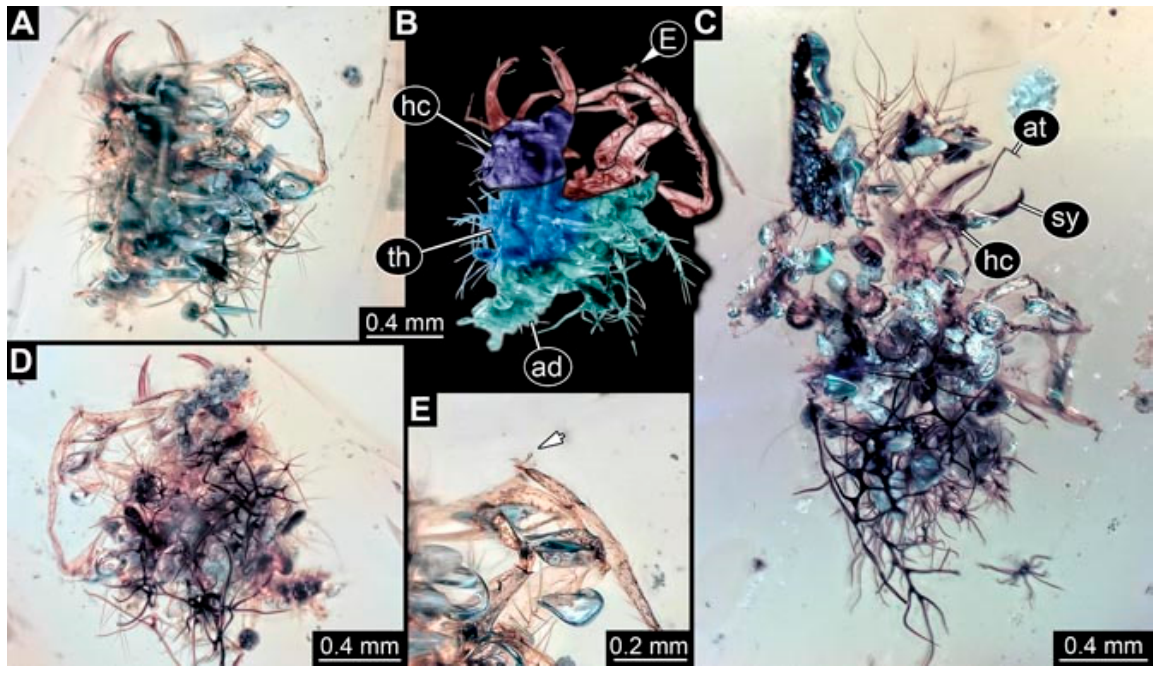
Figure 26. Specimen 4848 (PED 0642); Myanmar amber. ( A ) Dorsal view. ( B ) Dorsal view, colour- marked. ( C ) Ventro-lateral view. ( D ) Ventral view. ( E ) Close-up of trunk appendage with empodium (arrow). Abbreviations: ad = abdomen; at = antenna; hc = head capsule; sy = stylet; th = thorax.